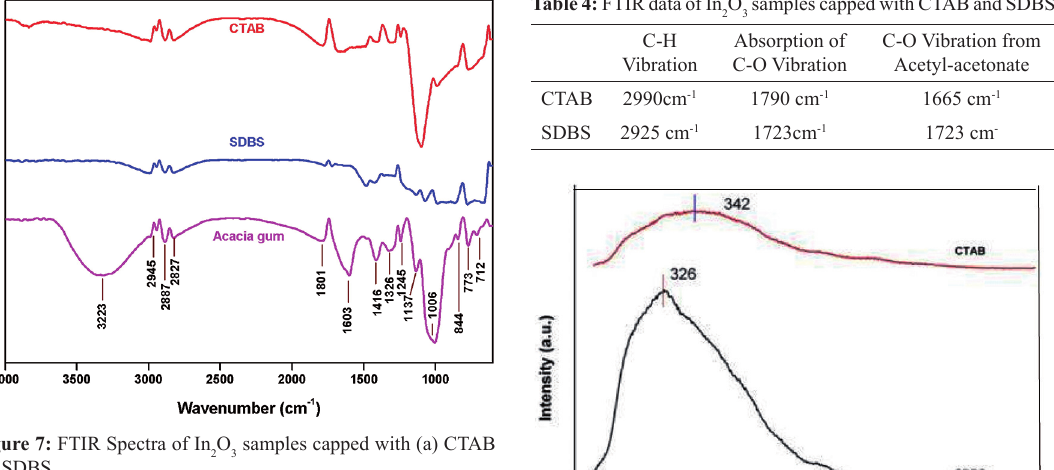
O samples capped with (a) UV-Vis absoption spectra of In 2 3 Table 4: FTIR data of In